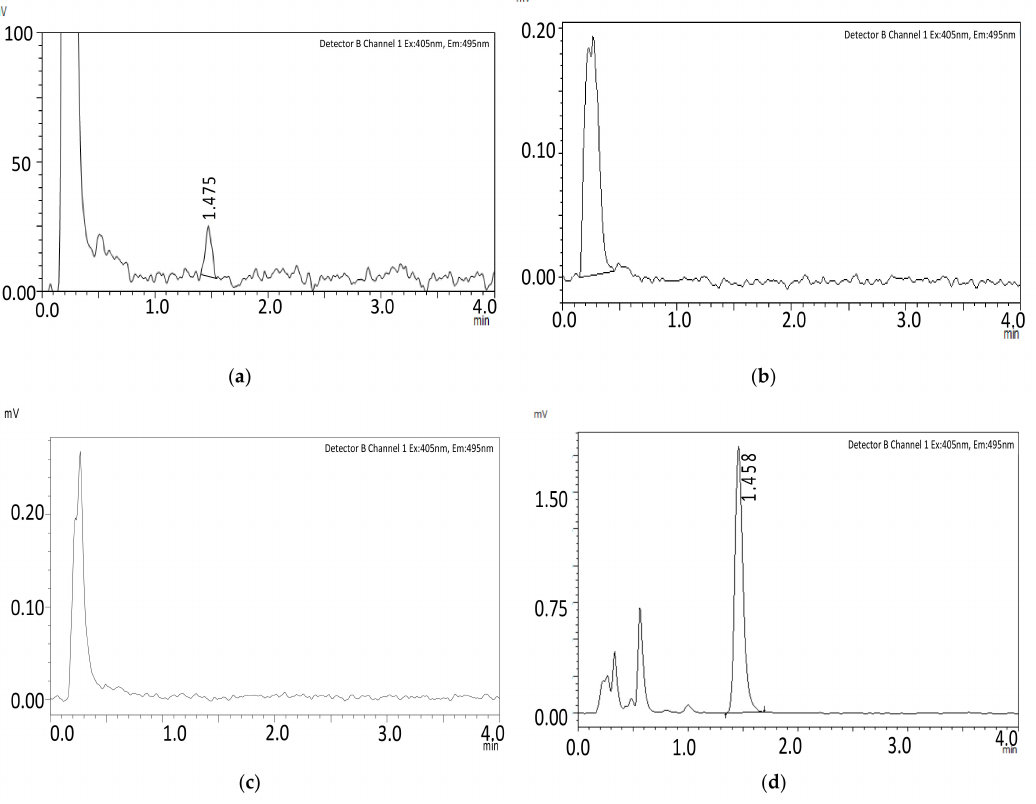
Figure 3. Representative HPLC-FLD chromatograms at excitation and emission wavelengths at 405 and 495 nm, respectively, for ( a ) plasma sample spiked with capmatinib (t R = 1.47 min) at LLOQ level (19.5 ng/mL); ( b ) blank plasma sample; ( c ) in vivo pre-dose plasma sample; ( d ) in vivo plasma sample obtained 1 h after oral administration of capmatinib to rat, concentration = 1700